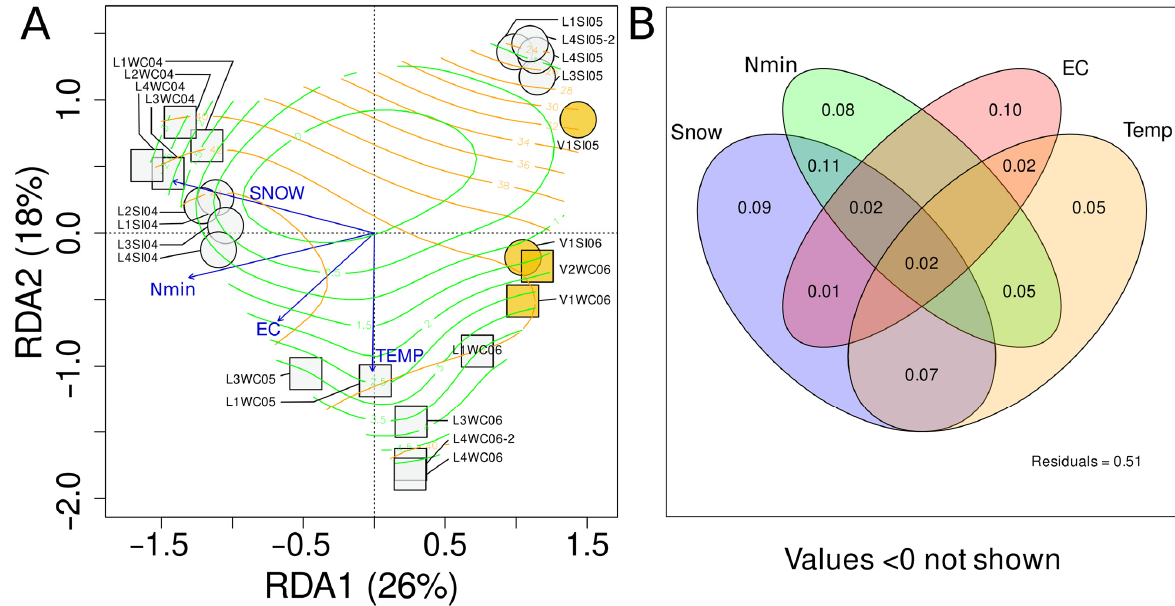
Figure 5. Constrained ordination of count matrix with 95 top-abundant OTUs (see Figure 3A,B). ( A ) Ordination plot computed with transformation-based RDA. Exploratory variables were chosen by “forward selection” approach and are indicated by the blue vectors. Point shape: SI—circle, WC—square. Point color: LL—grey, LV—yellow. Gradients of electric conductivity and temperature are drawn by orange and green isolines. Gradients of the first two model variables—Snow and N min —are not shown, as the are nearly linear. ( B ) Venn diagram describing the variation partitioning.